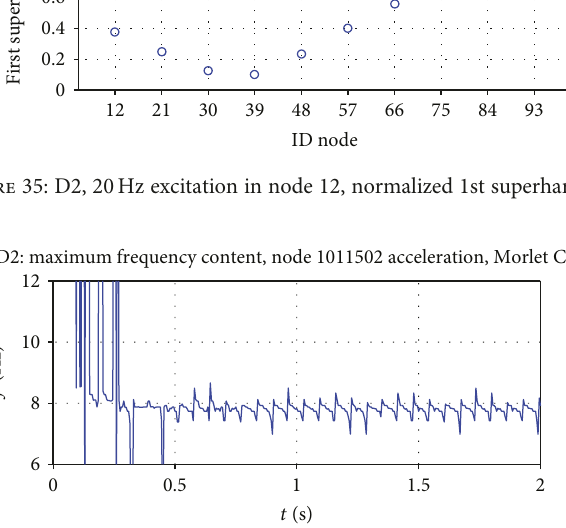
Figure 36: D2, decay test CWT, acceleration in the damaged node.